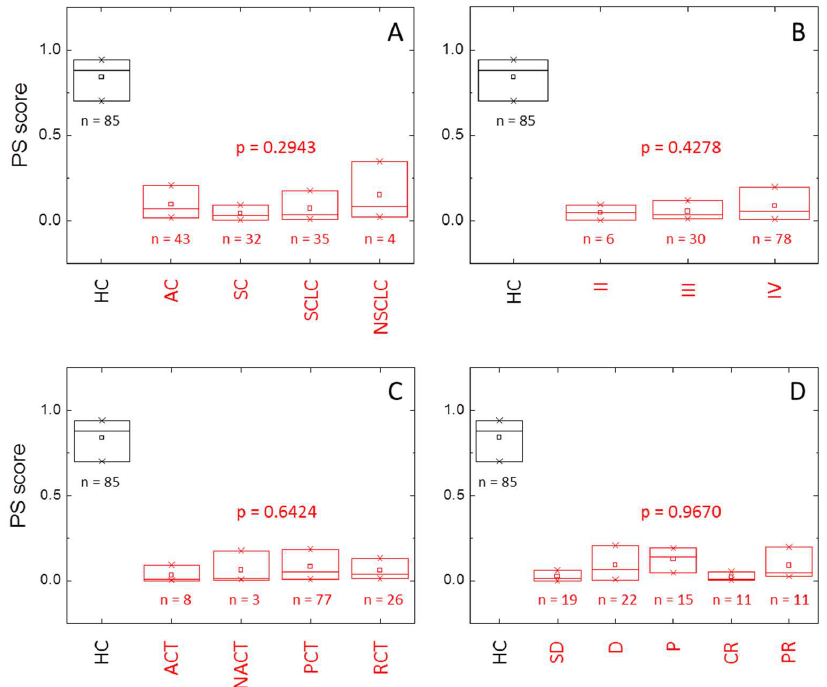
Figure 5. Distribution of the probability score (PS) within healthy individuals (HC group, black) and lung cancer patients (LCP group, red) according to ( A ) diagnostic (AC: adenocarcinoma, SC: squamous cell lung cancer, SCLC: small cell lung cancer, NSLC: other non-small cell lung cancer), ( B ) stage, ( C ) treatment (ACT: adjuvant chemotherapy, NACT: neoadjuvant chemotherapy, PCT: palliative chemotherapy, RCT: radio-chemotherapy), and ( D ) response (SD: stable disease, D: death, P: progression, CR: complete response, PR: partial response). The box-plot diagrams indicate Q 1 , Q 2 , and Q 3 , together with the average value (square). The number below each box is the number of subjects within each subgroup. The p -value (Kruskal – Wallis test) indicates there is no statistically significant difference between subcategories (diagnostic, stage, treatment, and response) within HC and LCP groups ( p > Table 7. Contingency table for clinical history information (probability score (PS) threshold = 0.5). PS > 0.5 PS < 0.5 Group Diagnostic p -Value False Negatives True Positives